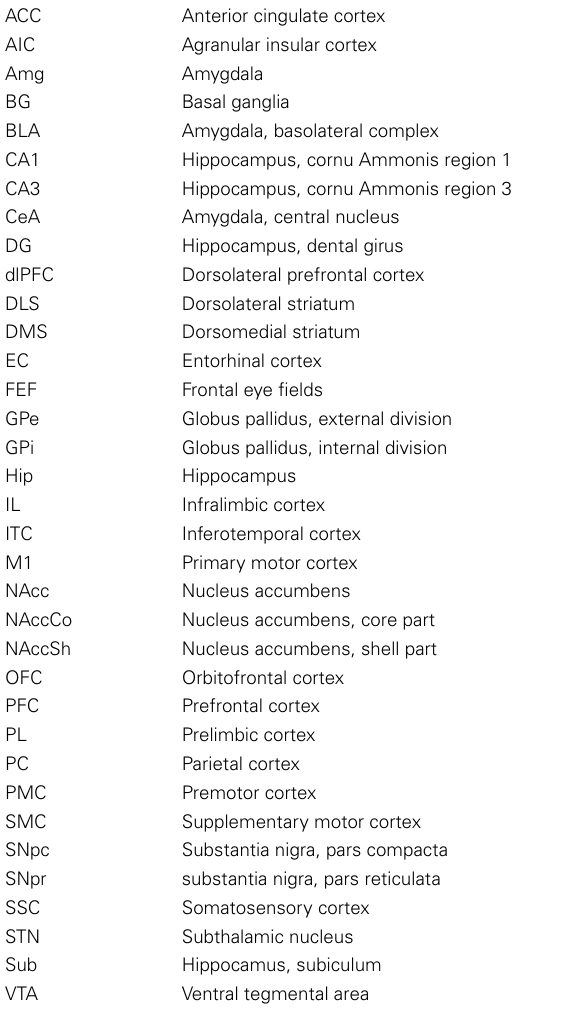
Table A1 | Acronyms used in the paper to indicate various components of